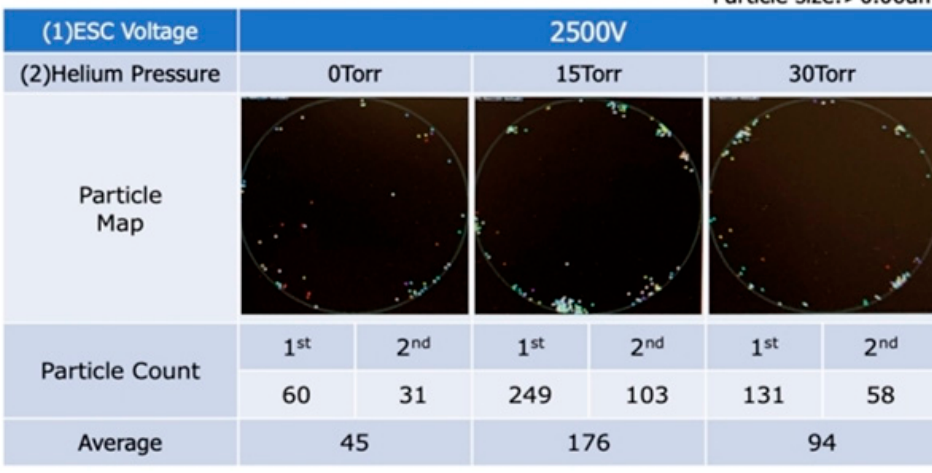
Figure 10. Particle distributions under different helium pressures at an ESC voltage of 2500 V.